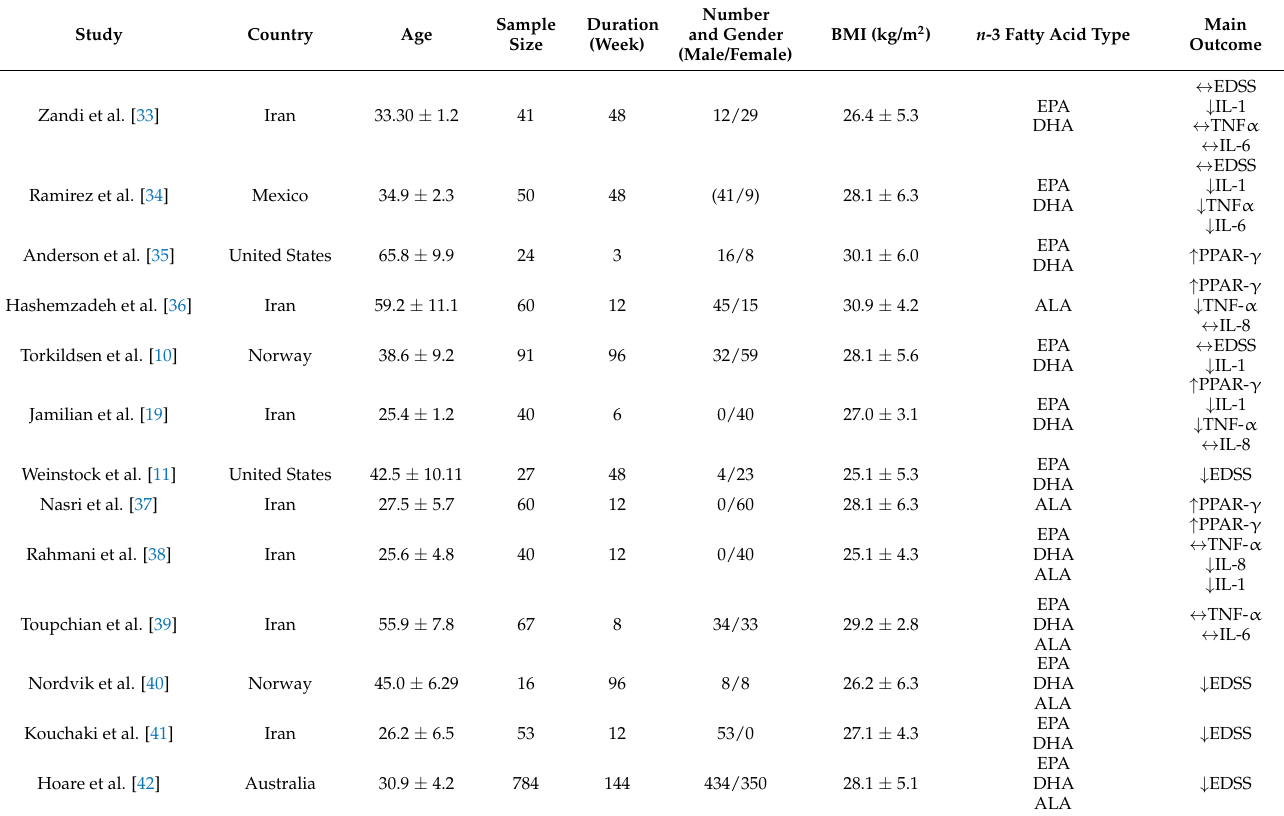
Table 1. Characteristics of the identified prospective studies of omega-3 FAs and score of EDSS or inflammatory gene